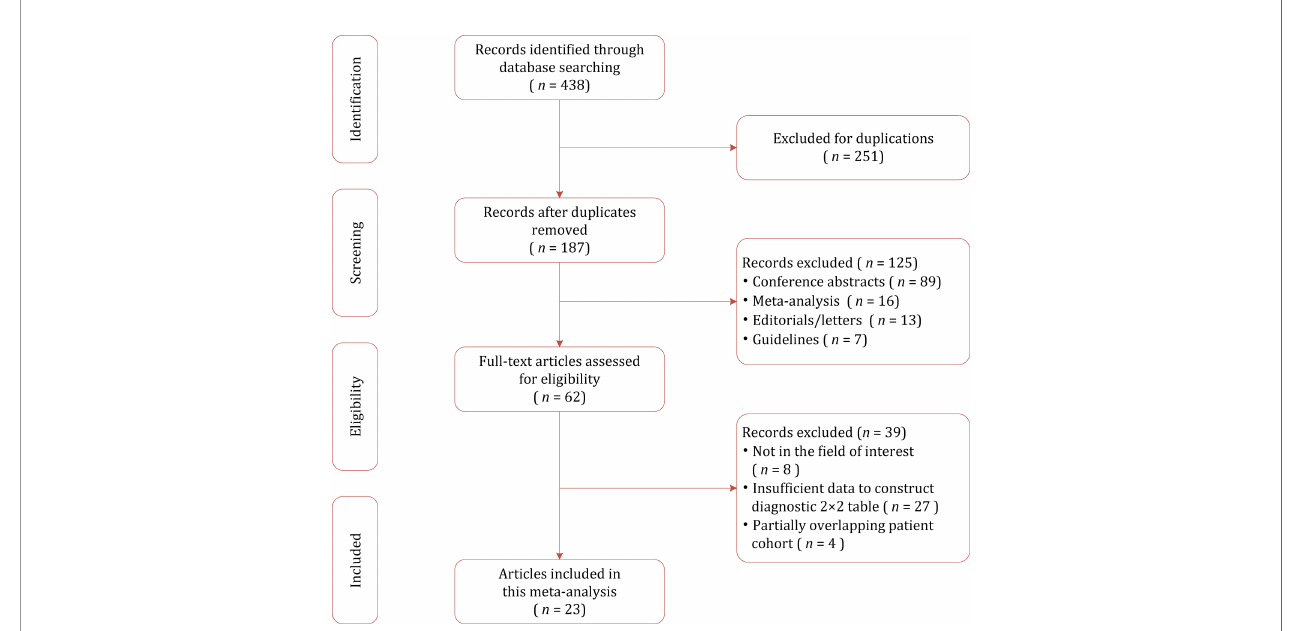
FIGURE 1 | Study selection process for this systematic review and